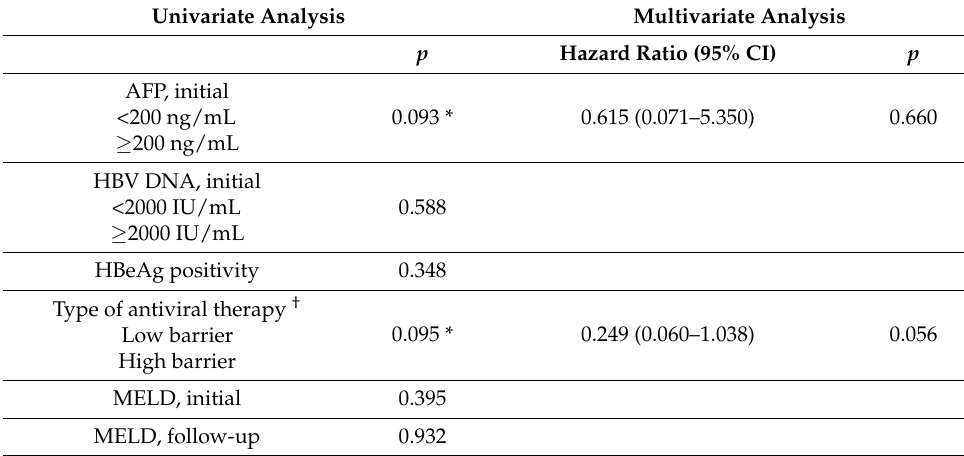
Table 6. Cont . Univariate Analysis Multivariate